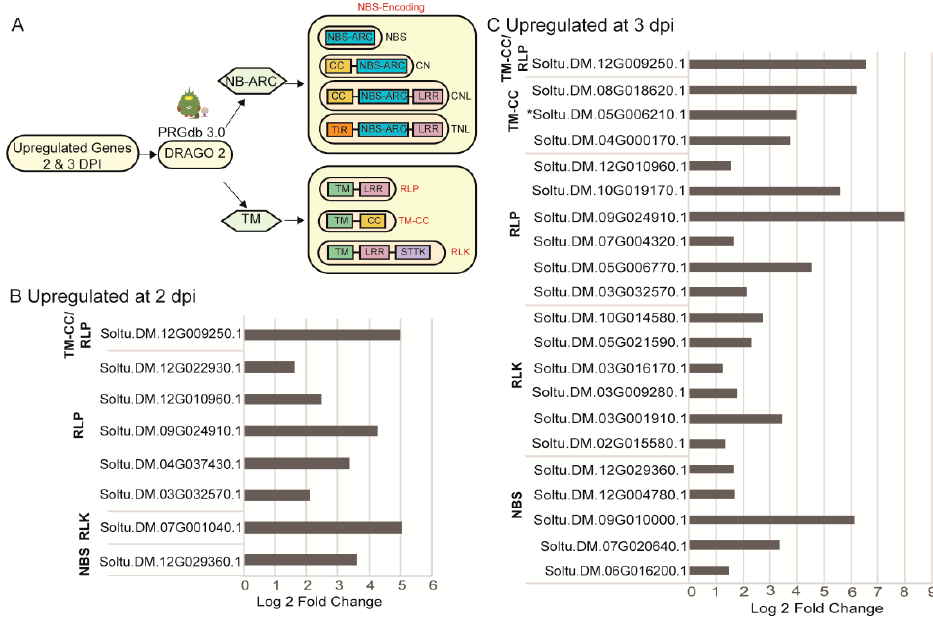
Figure 5. Upregulated RGAs identified using the DRAGO 2 pipeline. ( A ) Diagrammatic representation of the discovery pipeline based on protein domains such as nucleotide-binding site (NB-ARC), leucine-rich repeat (LRR), transmembrane domain (TM), coiled-coil (CC), Toll/Interleukin-1 receptor (TIR), lysin motif (LysM), and the serine/threonine and tyrosine kinase (STTK). RGA categories are identified in red: NBS-encoding, RLP, TM-CC, or RLK. Subcategories within the NBS- encoding genes are identified inside yellow bubbles. ( B , C ) Bar graphs show genes that were upregulated at 2 and 3 dpi, respectively. The putative gene families are identified on the left. Asterisk places next to Sotu.DM.05G006210 identifies a gene that is classified at TM-CC but also has an NB-ARC domain so it potentially can be classified as a